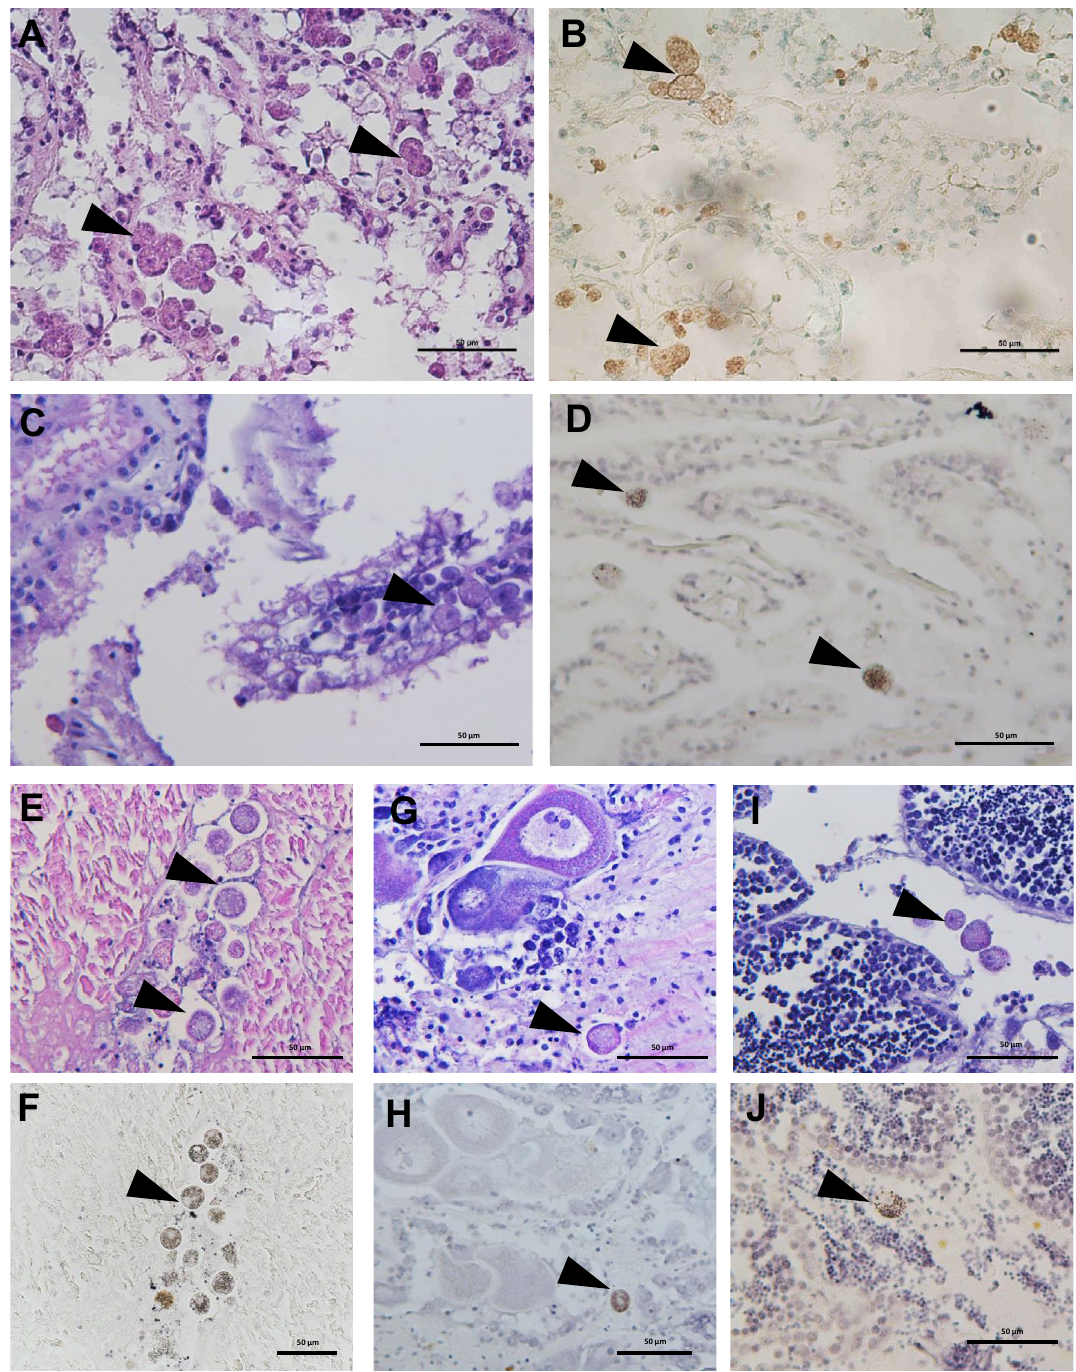
Figure 4. Micrographs of histological sections presenting BSM infection in different scallop tissues using H&E stain ( A , C , E , G and I ) and in situ hybridization ( B , D , F , H , and J ). ( A ) and ( B ): kidney, ( C ) and ( D ): gills, ( E ) and ( F ): adductor muscle, ( G ) and ( H ): ovary, ( I ) and ( J ): testis. The black arrowheads indicate parasite